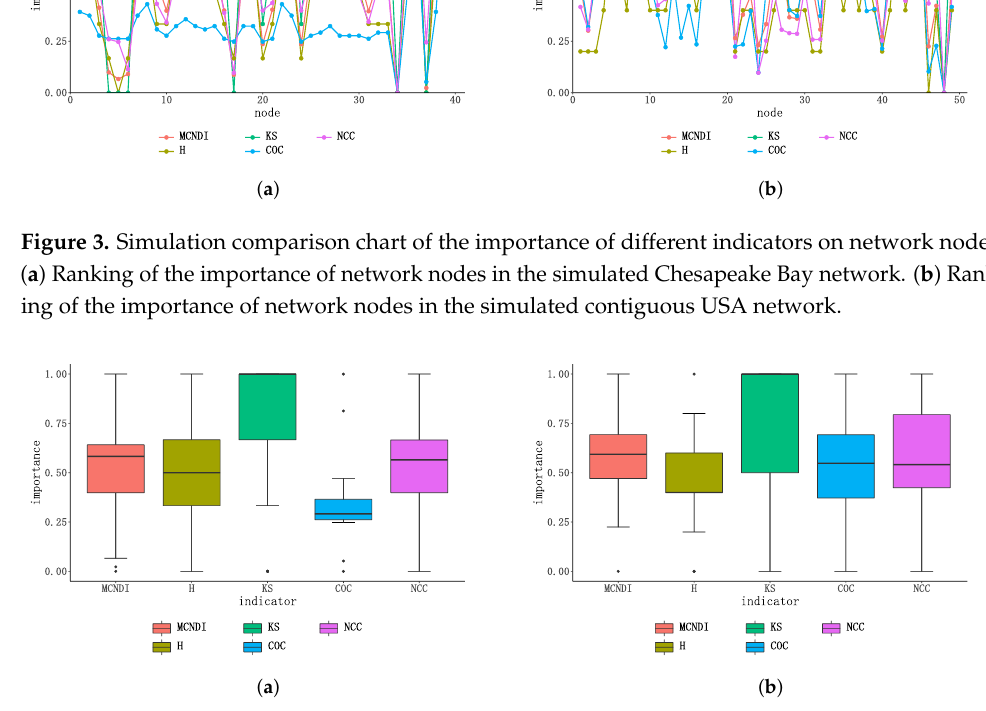
Figure 4. Simulated distribution of different metrics on the importance ranking of network nodes. ( a ) Importance distribution of network nodes in the simulation of the Chesapeake Bay network. ( b ) Importance distribution of network nodes in the simulation of the contiguous USA